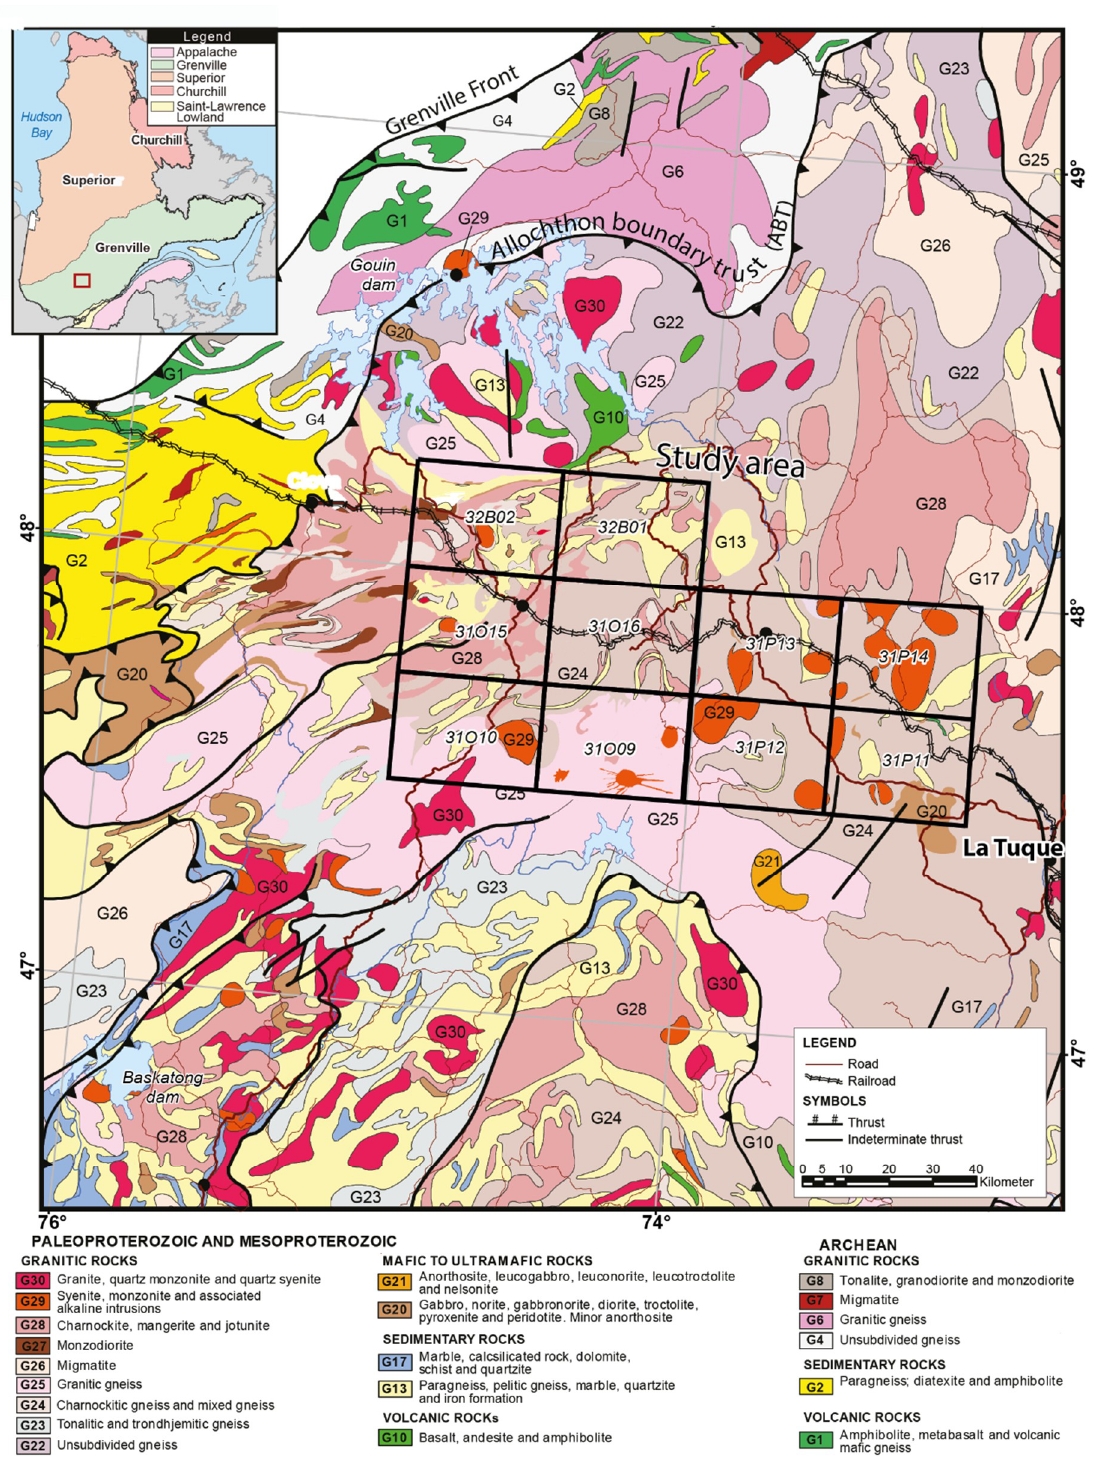
Figure 1. Regional geology showing the study area located in the allocthon part of the Grenville Province. This figure shows the position of the study area relative to the allochton boundary trust and the central metasedimentary belt in the south. The alkaline intrusion corresponds to the G29 red-orange intrusion.